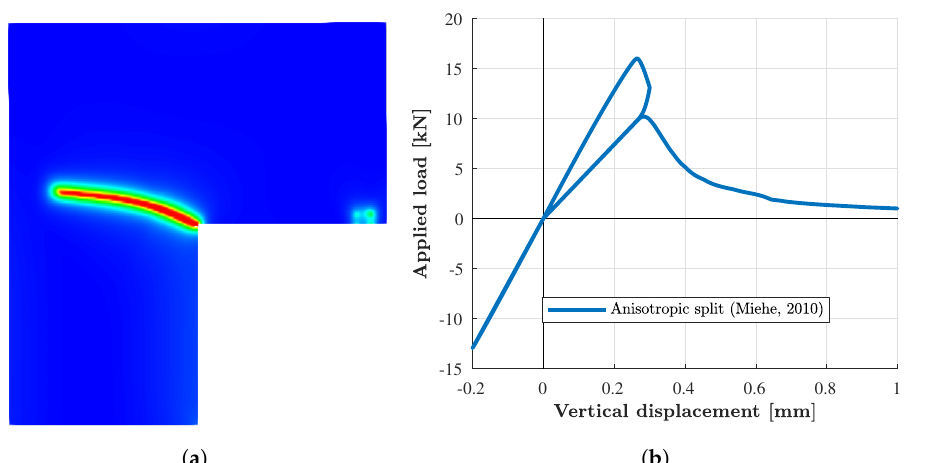
Figure 35. ( a ) LSP phase field ( b ) load-deflection response under the cyclic loading defined in Figure 31 b